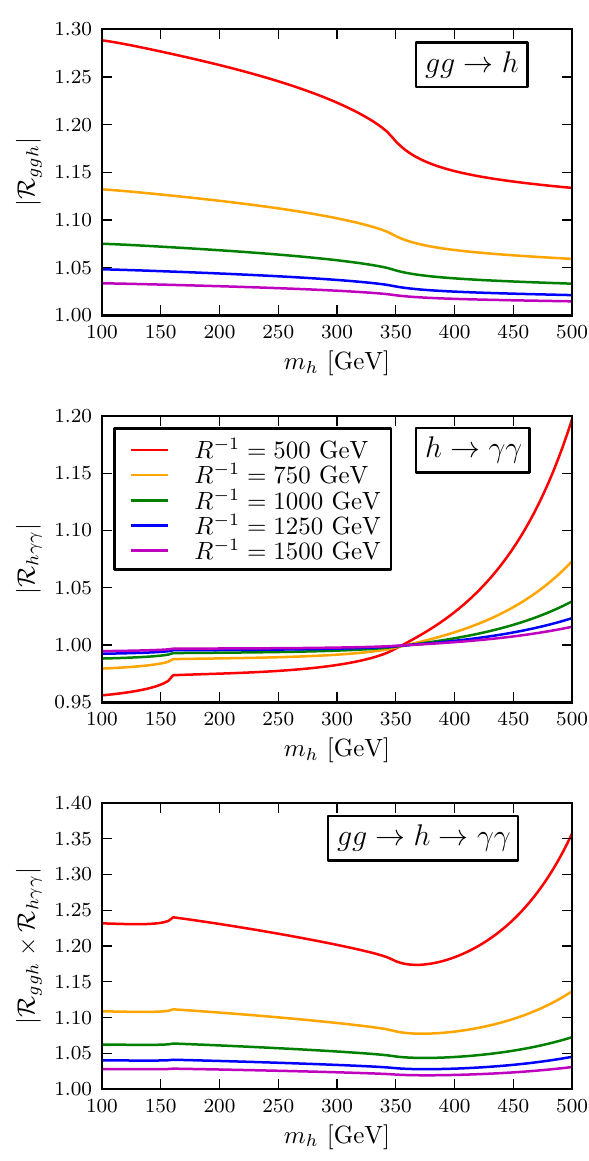
Fig. 2. Ratios of the scalar parts of matrix elements for Higgs production and decay, where R = ˜ M MUED / ˜ M SM . For each graph, on the RHS, from top to bottom, the curves represent R − 1 values of 500, 750, 1000, 1250 and 1500